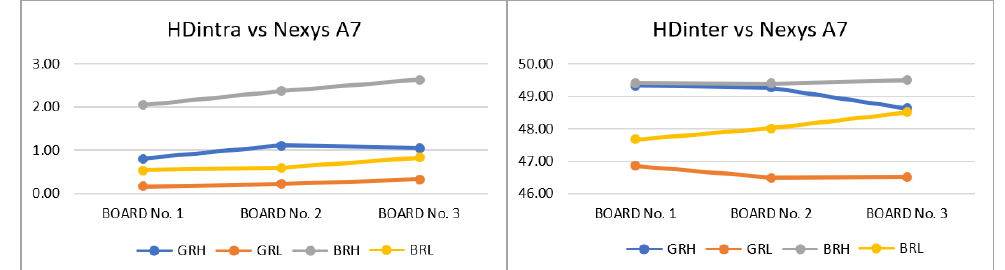
Figure 19. HDintra mean ( left ) and HDinter mean ( right ) under the same operation conditions, applying the challenge selection strategy on the test system implemented in three different Nexys A7 boards.